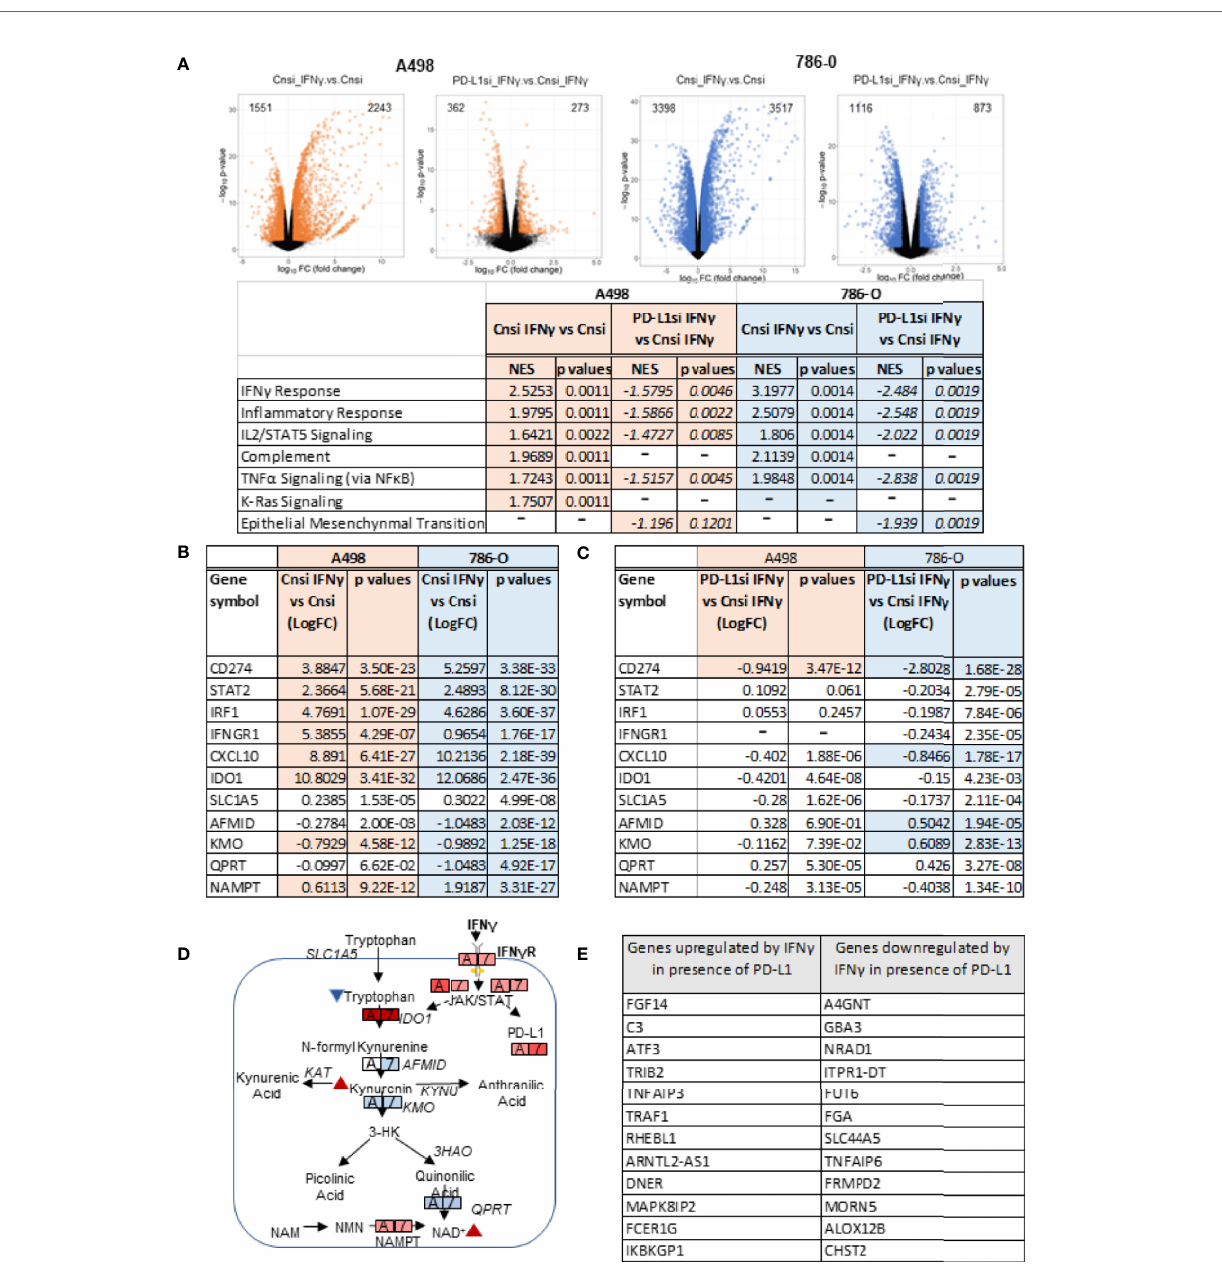
FIGURE 4 | Transcriptional effects of IFN g treatment with or without PD-L1 silencing. (A) Volcano plots depicting the number of genes upregulated and downregulated in A498 and 786-O cells with PD-L1 expression (Cnsi_IFN g vs Cnsi) and with silenced PD-L1 expression (PD-L1si_IFN g vs Cnsi_IFN g ) (n=3, for each group). The GSEA analysis indicating upregulated signaling pathways with IFN g treatement in A498 and 786-O cells is shown in the table below the volcano plots, “ - ” , data not determined; RNA-Seq differential expression of genes (DEG) in A498 and 786-O cells with high PD-L1 expression (Cnsi_IFN g vs Cnsi) are shown in (B) and with silenced PD-L1 expression (PD-L1si_IFN g vs Cnsi_IFN g ) are shown in (C) , “ - ” , data not determined. (D) illustration of the effect of IFN g on tryptophan metabolism; (E) Genes regulated by IFN g in a PD-L1 dependent